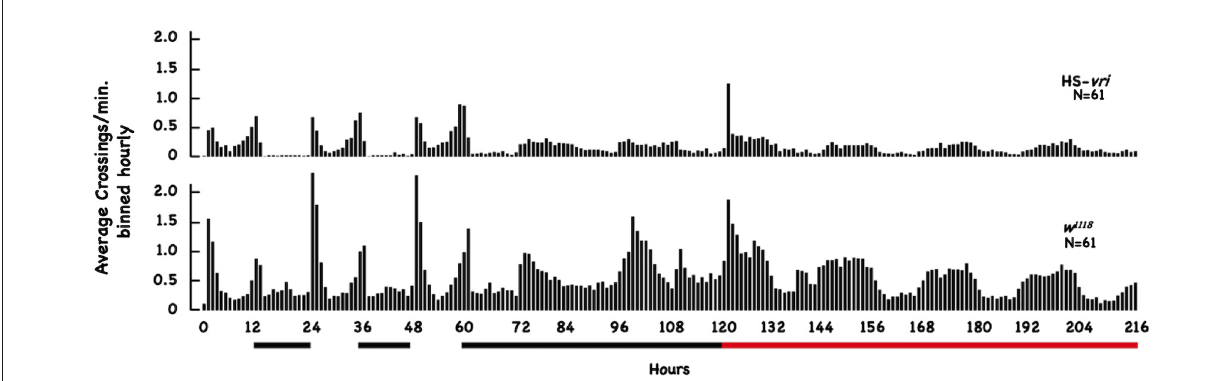
FIGURE5 Effect of HS- vri induction on locomotor activity. Flies ( w 1118 and HS- vri ) were placed into the DAM apparatus to measure locomotor activity. The average number of beam crossings per minute binned in hourly units was calculated and plotted as a function of elapsed time. The black horizontal lines under the Figure indicate dark periods (hours 12–24 and 36–48) and constant darkness (hours 60–120). The red bar indicates constant darkness plus heat-shock (a 20 ◦ C to 28 ◦ C chronic shift beginning at the 120th h). The N sizes for each group are